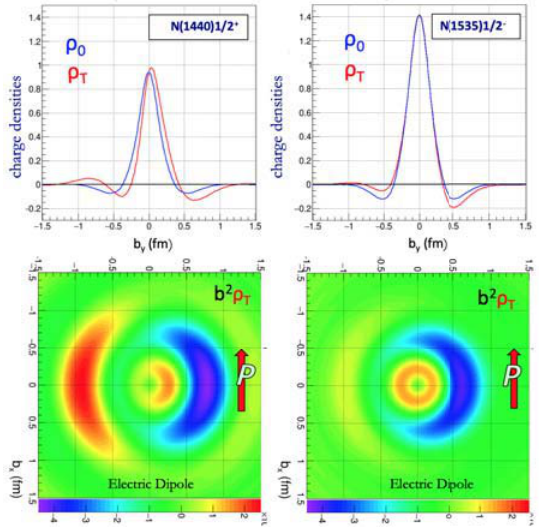
Fig. 17 The transverse amplitude A 1 / 2 for the N (1535) 1 2 resonance compared to LF RQM calculations (solid line) and QCD computation within the LC Sum Rule approach.